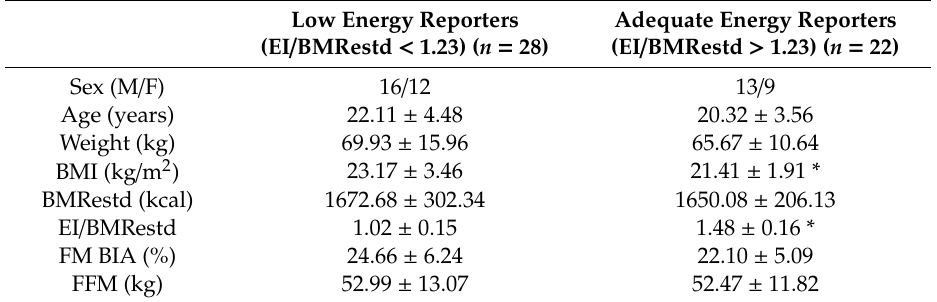
Table 2. Anthropometric and body composition characteristics of athletes classified as low and adequate energy reporters based on the ratio of energy intake to the estimated basal metabolic rate (Mean ± DS).